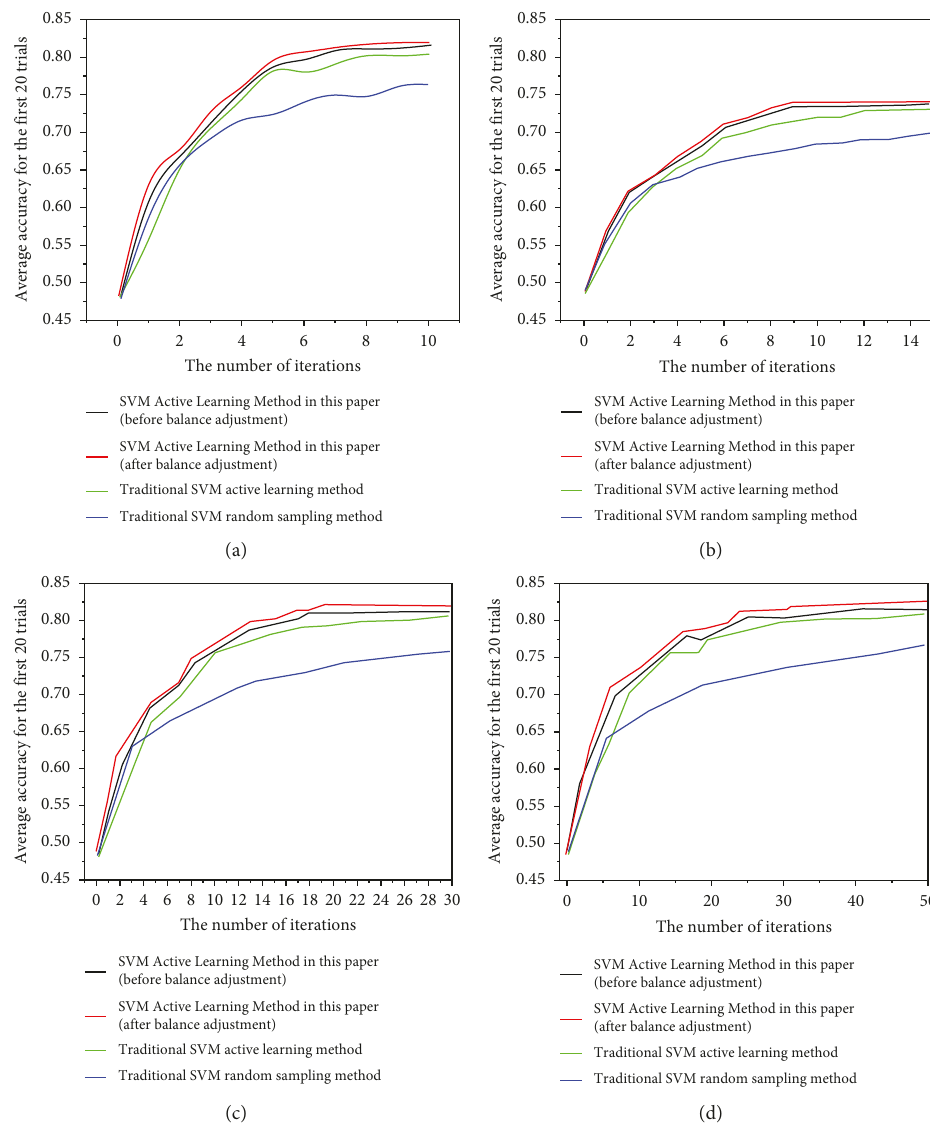
Figure 10: Comparison of classification accuracy and convergence speed of three methods. (a) m � 150; (b) m � 100; (c) m � 50; (d) m �